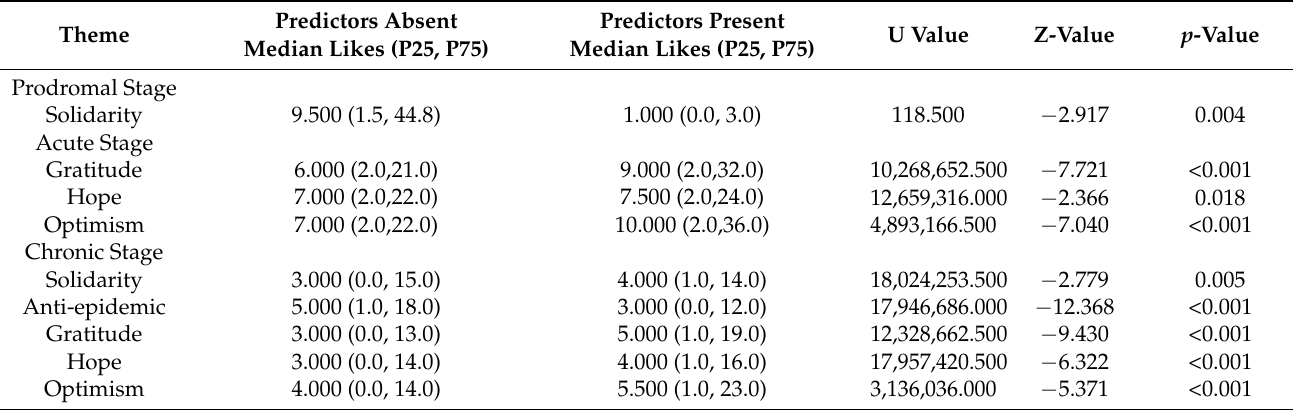
Table 3. Public engagement on Facebook postings with or without positive themes at different crisis stages in Macao (1 January to 31 December 2020).